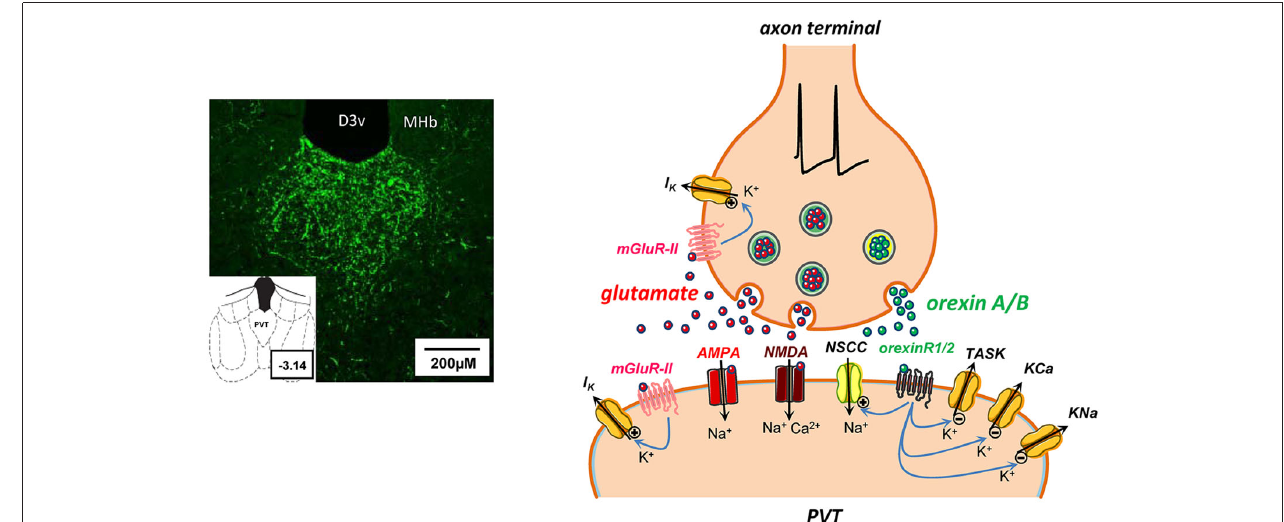
FIGURE 3 | Some potential consequences of glutamate and orexin co-release at a synapse in PVT . On the left, microphotograph of coronal section from rat brain (bregma ∼ − 3.14) reveal a dense distribution of orexin A-immunoreactive fibers in PVT nucleus. Abbreviations: D3v, dorsal 3rd ventricle; MHb, medial habenula. On the right, schematic synapse depicting action potential invasion of an axon terminal in PVT containing storage vesicles for a rapid transmitter (glutamate, red symbols) and a neuropeptide (orexin A or B, green symbols). Presynaptically released glutamate diffuses across the synaptic cleft to act at postsynaptic ionotropic AMPA and